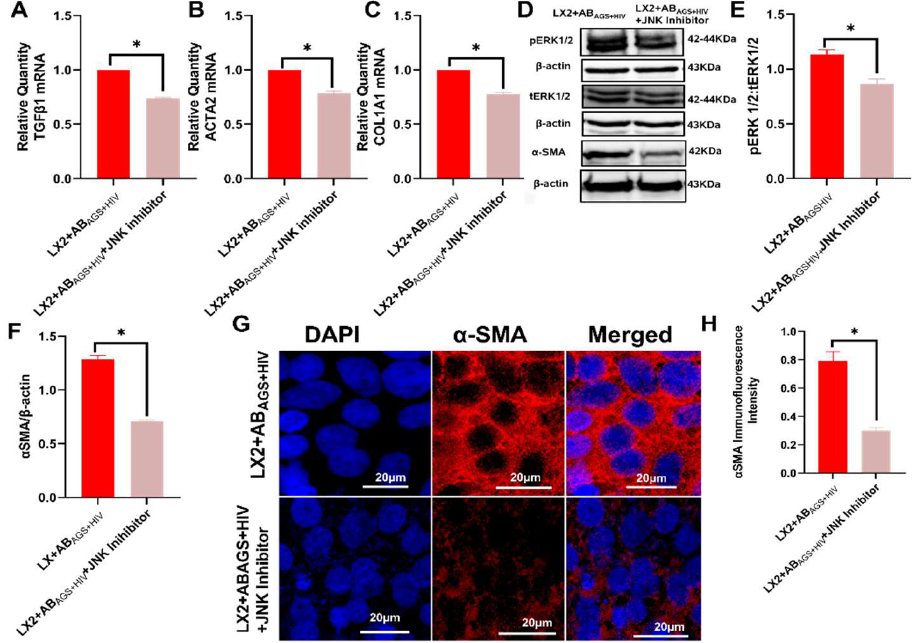
Figure 6. Attenuation of profibrotic markers in LX2 cells exposed to AB AGS+HIV by pharmacological inhibition of JNK pathway : RT-PCR analysis of ( A ) TGFβ1 mRNA, ( B ) ACTA2 mRNA, and ( C ) COL1A1 mRNA. ( D – F ) Phopho-ERK1/2 and α-smooth muscle actin were measured by immunoblot analysis and immunoreactive blots were quantified. Equal amounts of protein (20 µg) were loaded in each lane. β-actin was used as an internal control. ( G ) Immunofluorescent staining of α-smooth muscle actin. Staining was visualized using a Keyence BZ-X810 fluorescence microscope. Pictures are representative data from three independent experiments. ( H ) Quantification of SMA was measured using NIH ImageJ. Data are from 3 independent experiments presented as mean ± SEM. Bars marked with the same letter are not significantly different. Bars with * are significantly different from each other ( p ≤ 0.05).